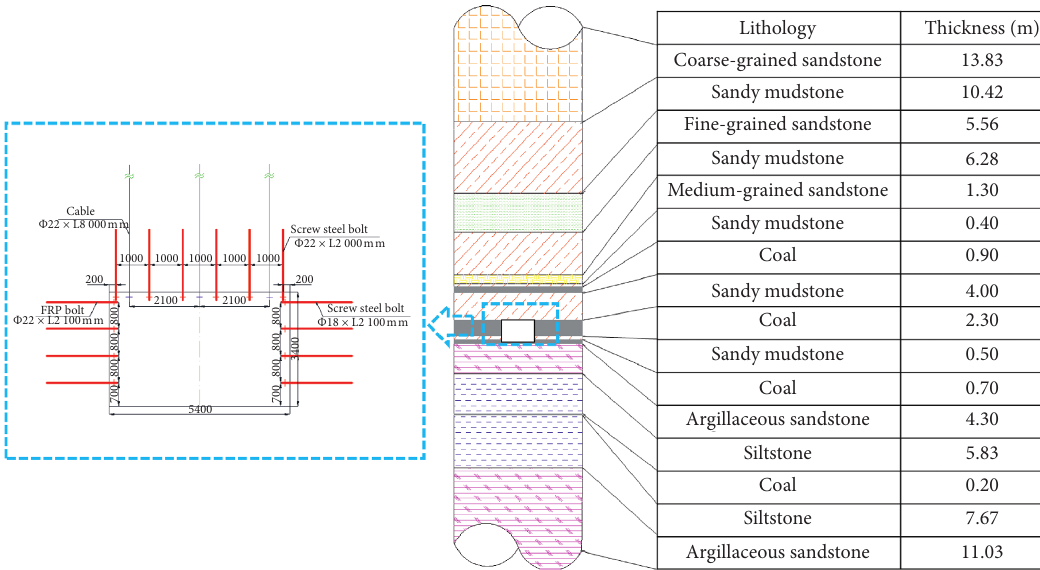
Figure 2: Generalized geological column and support structure of roadway.